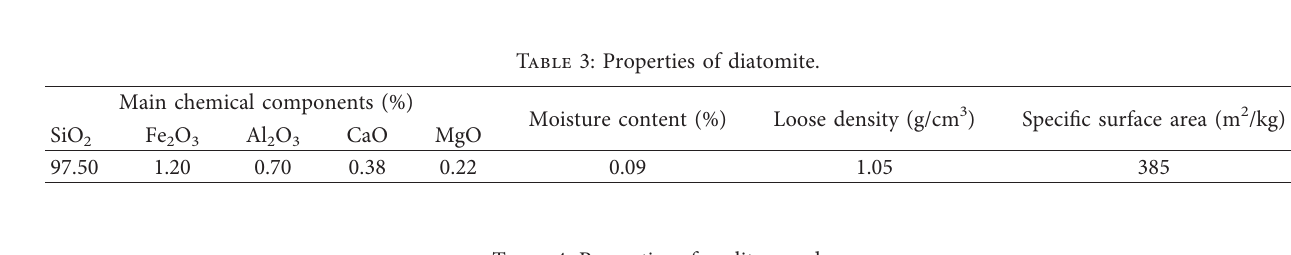
Table 4: Properties of zeolite powder.